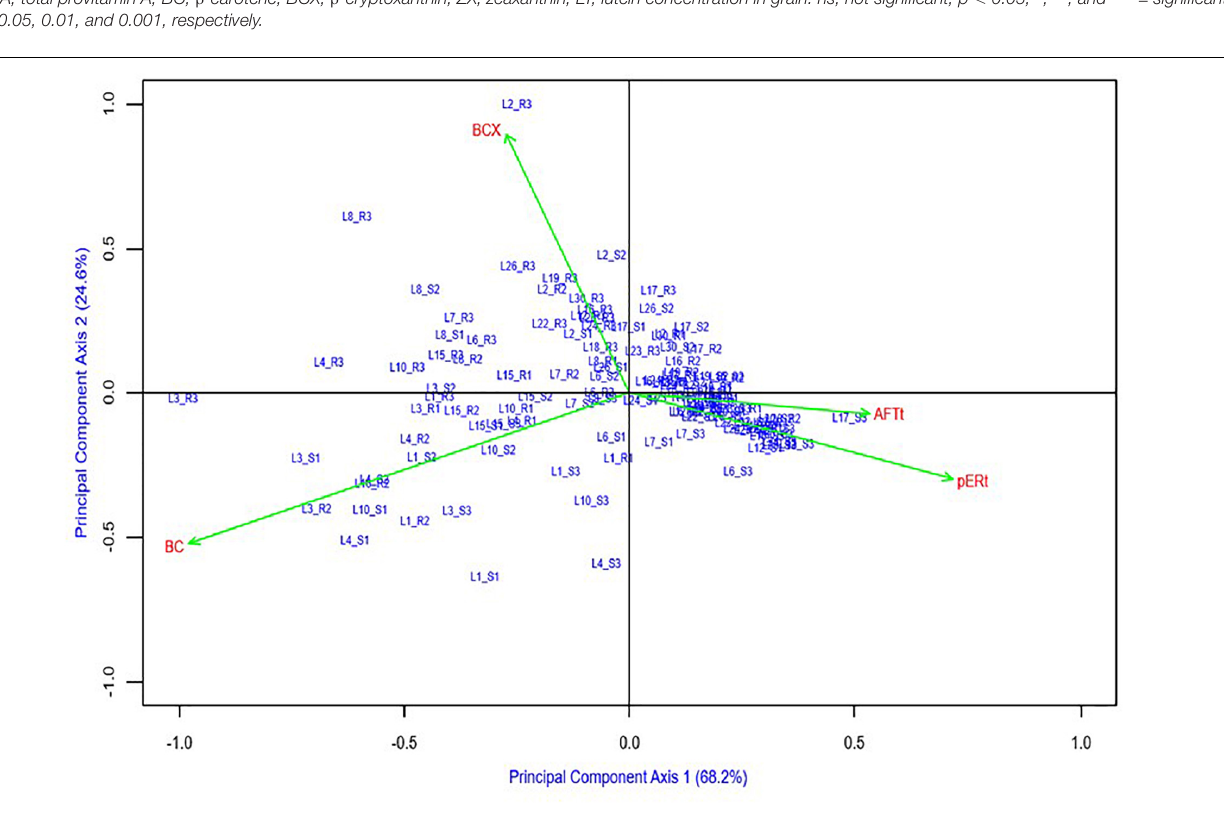
FIGURE 2 | Additive main effects and multiplicative interactions (AMMI) biplot of hybrids and four traits: aflatoxin concentration in grain [AFTt, log(AFT+1)], A. flavus ear rot symptom scores [pERt, sqrt(pER)], β -carotene (BC), β -cryptoxanthin (BCX) concentration in